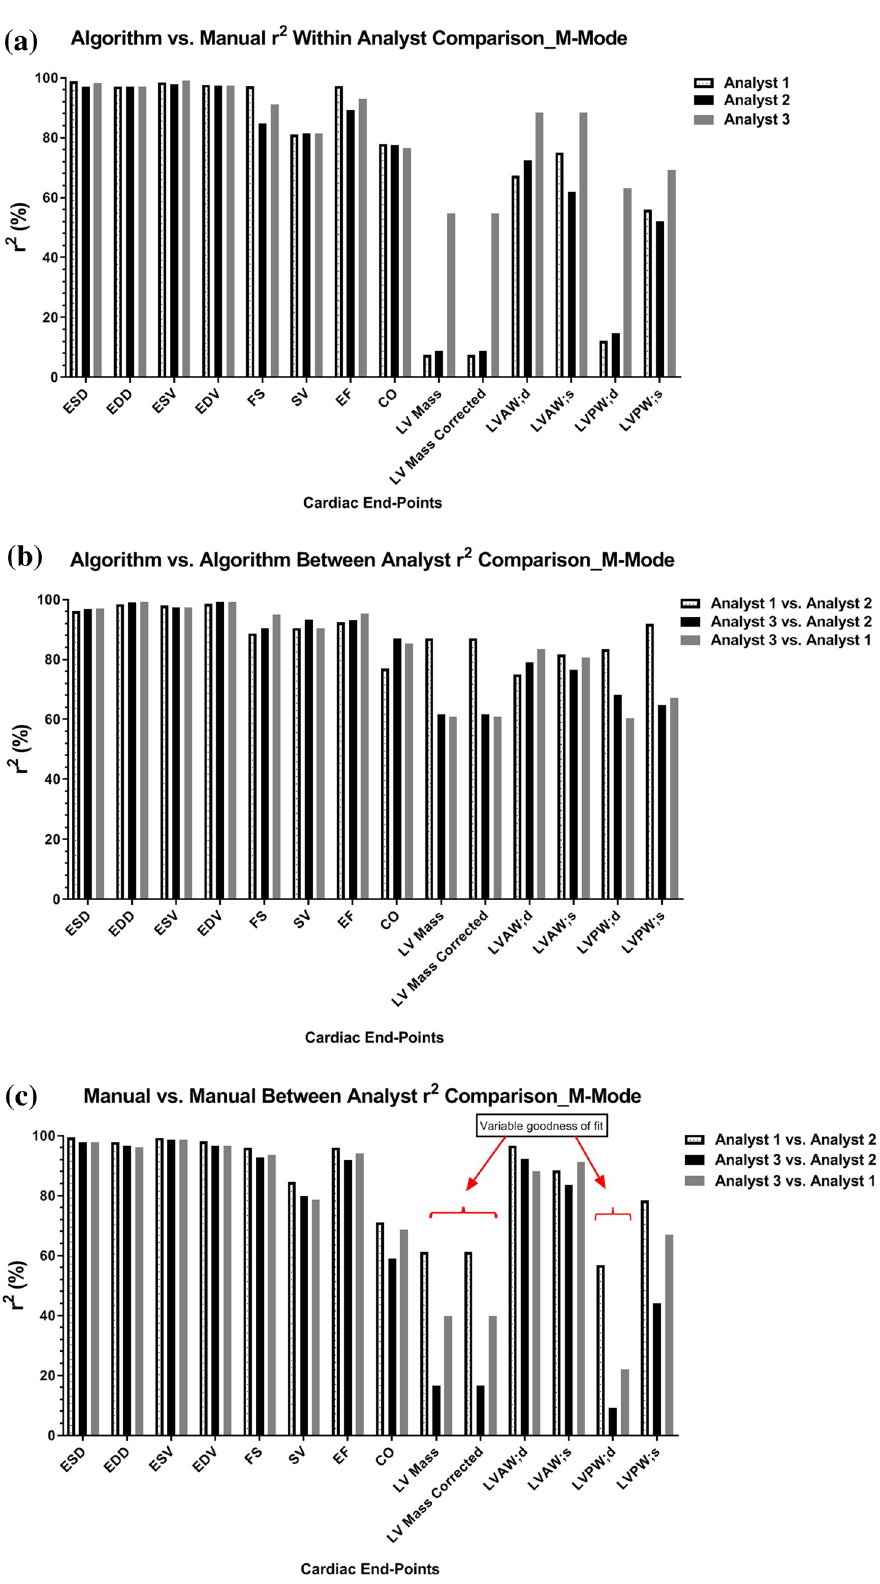
Figure 4. M-mode Segmentation Comparisons: Graphical representations of M-mode coefficient of determination among three analysts, with r 2 values on the y-axis and short axis LV structure and function end-points on the x-axis. ( a ) Displays the within analyst comparison of left ventricle M-mode echocardiograms segmented using the semi-automated algorithm compared to manual segmentation. ( b ) Shows the between analyst comparison while employing the algorithm for segmentation. ( c ) Shows the between analyst comparison when manual segmentation is performed; p values set at p < 0.05. Red brackets highlight variation in structural end-points resulting in a variable goodness of